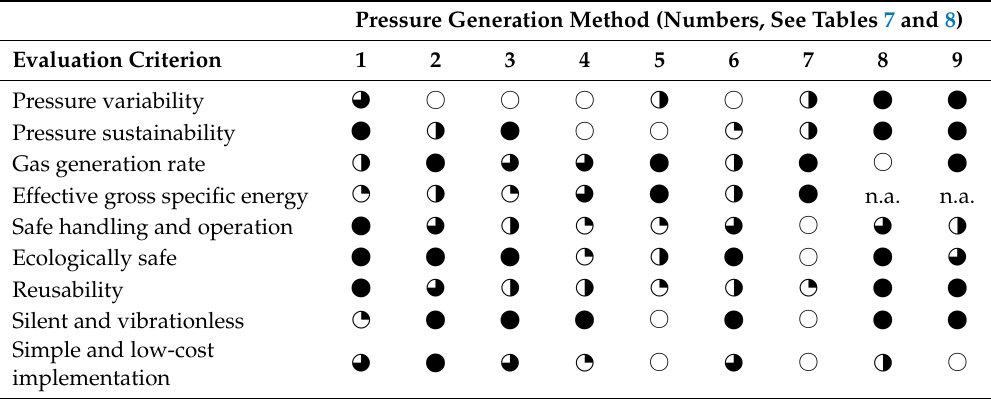
Table 9. Qualitative evaluation and comparison of all presented pressure generation methods. Pressure generation method (numbers, see Tables 7 and 8) Evaluation criterion Pressure variability